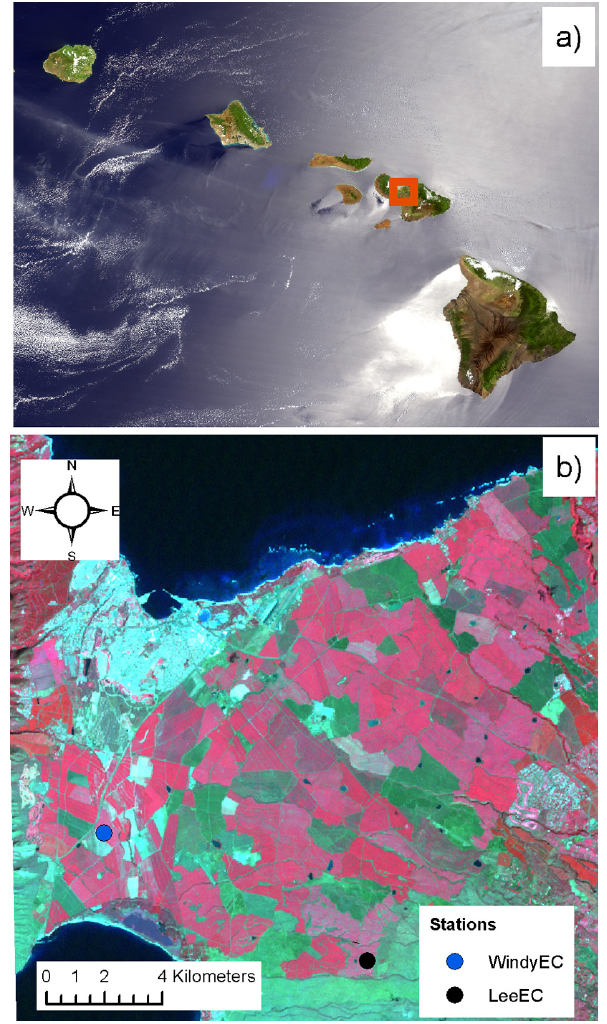
Figure 1. (a) True color image of the main Hawaiian islands from the moderate resolution imaging spectroradiometer (250m resolu- tion – image date: 27 May 2003). Study region is outlined in red box. (b) The study region on central Maui showing the location of the eddy covariance towers (Windy and Lee) used in this study. Im- age is false color Landsat 7 (30m resolution – image date: 5 Febru- ary